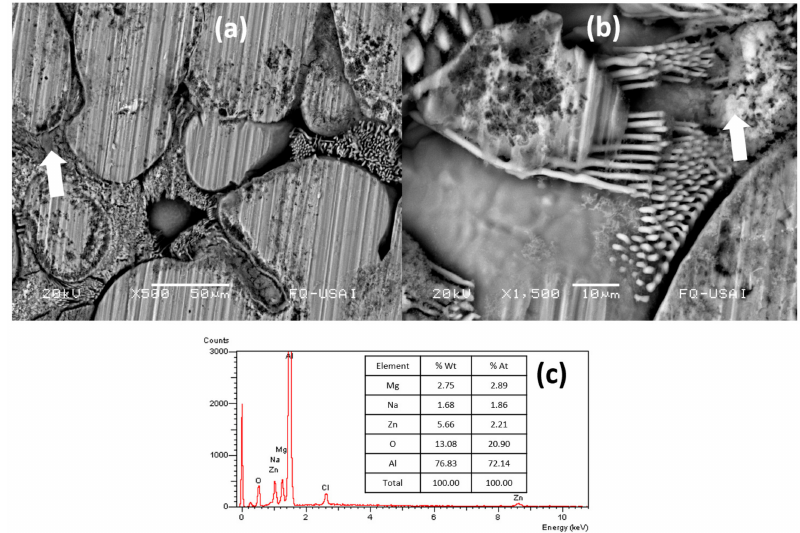
Figure 10. Micrographs and EDS recorded when stopped at a fixed current density ( a ) low magnification, ( b ) high magnification, and ( c ) microanalysis of the corrosion products from series